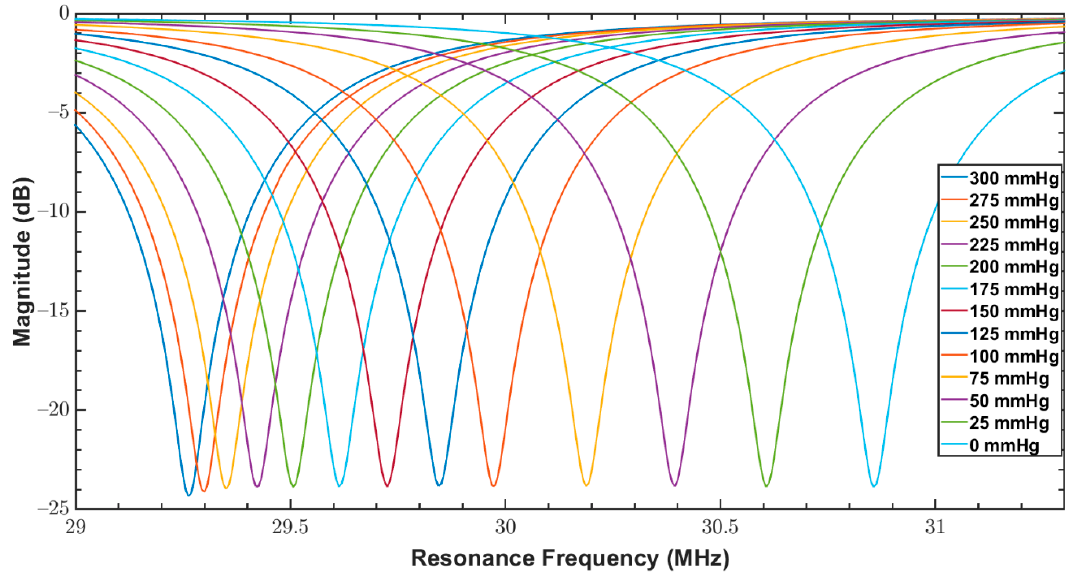
Figure 13. Reflection coefficients (S11 parameter) of S 1 for a pressure range between 0 to 300 mmHg.